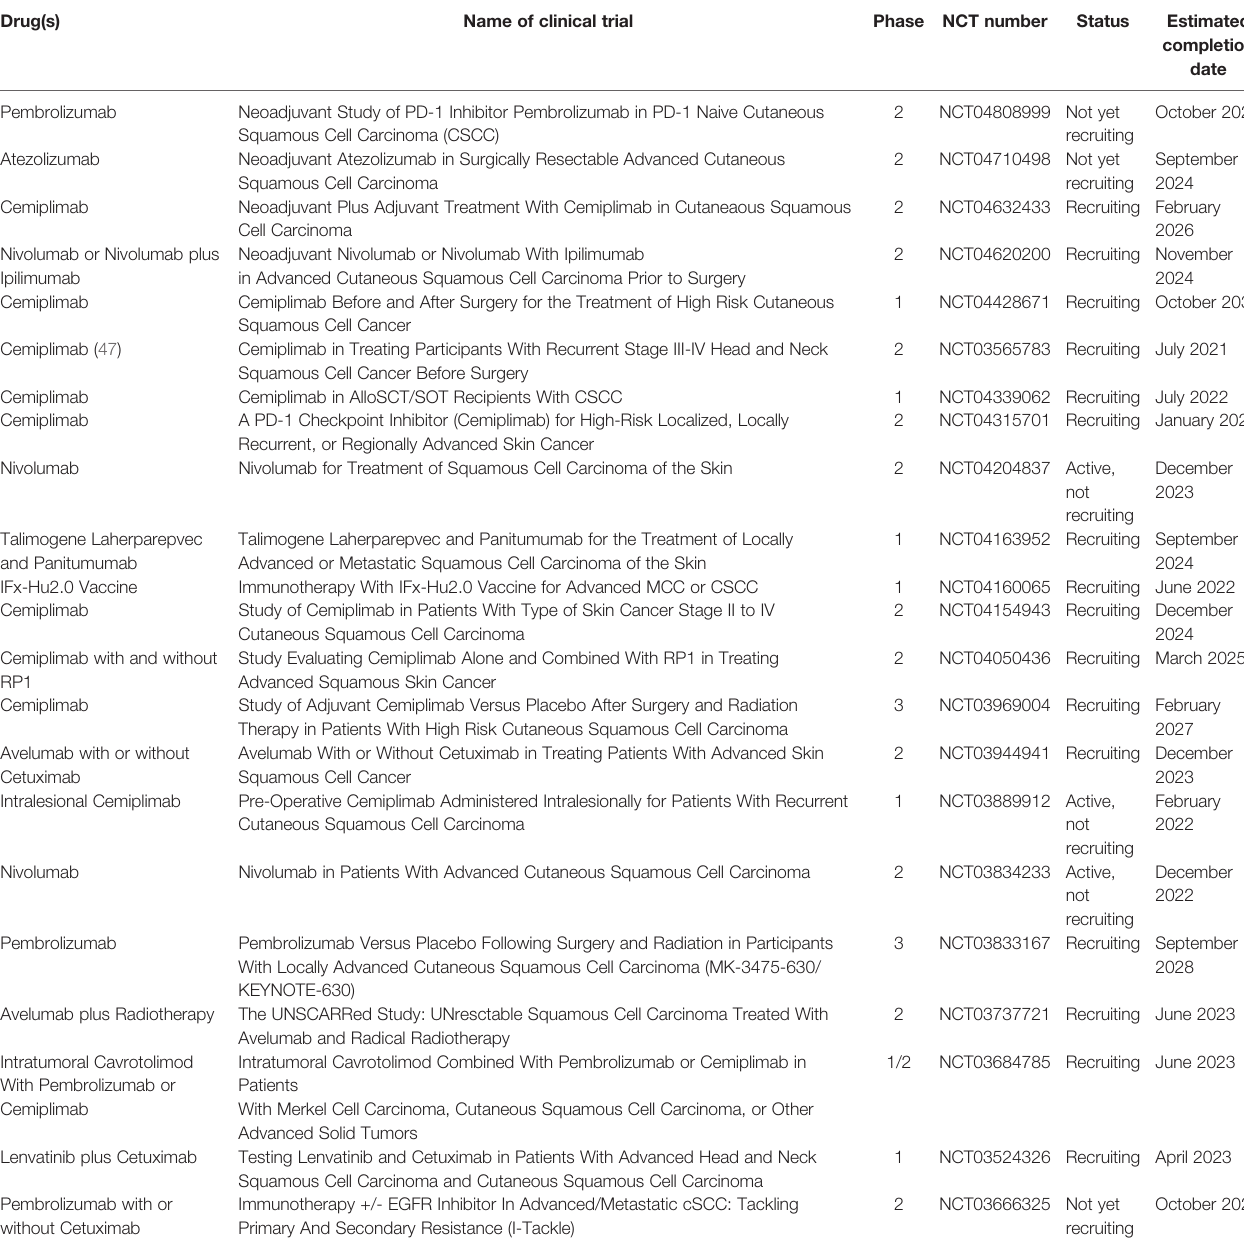
TABLE 2 | The principal ongoing clinical studies recruiting patients with advanced or high risk CSCC.